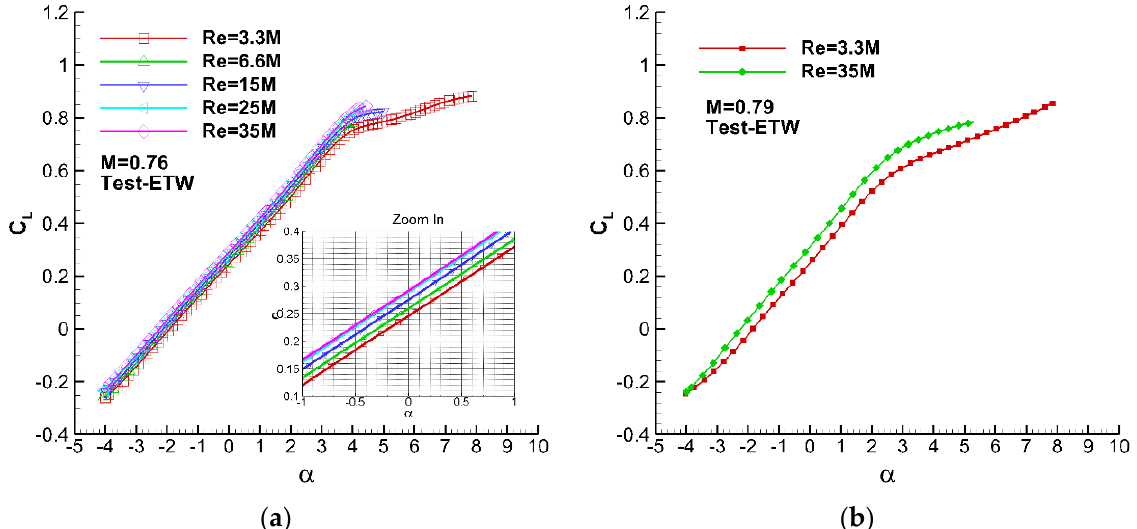
Figure 18. Typical lift coefficient curves at different Reynolds numbers: ( a ) M = 0.76; ( b ) M = 0.79.